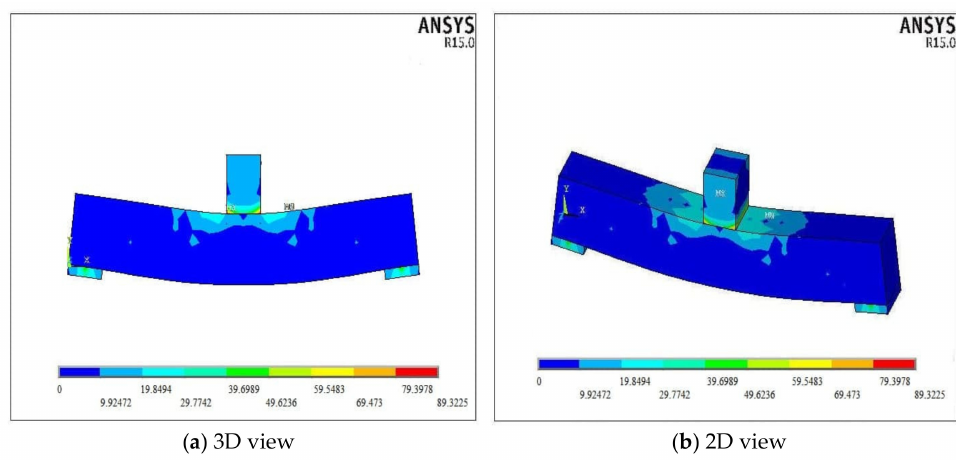
Figure 7. 3D and 2D von Mises stress contours of the control beam model B1 at failure.